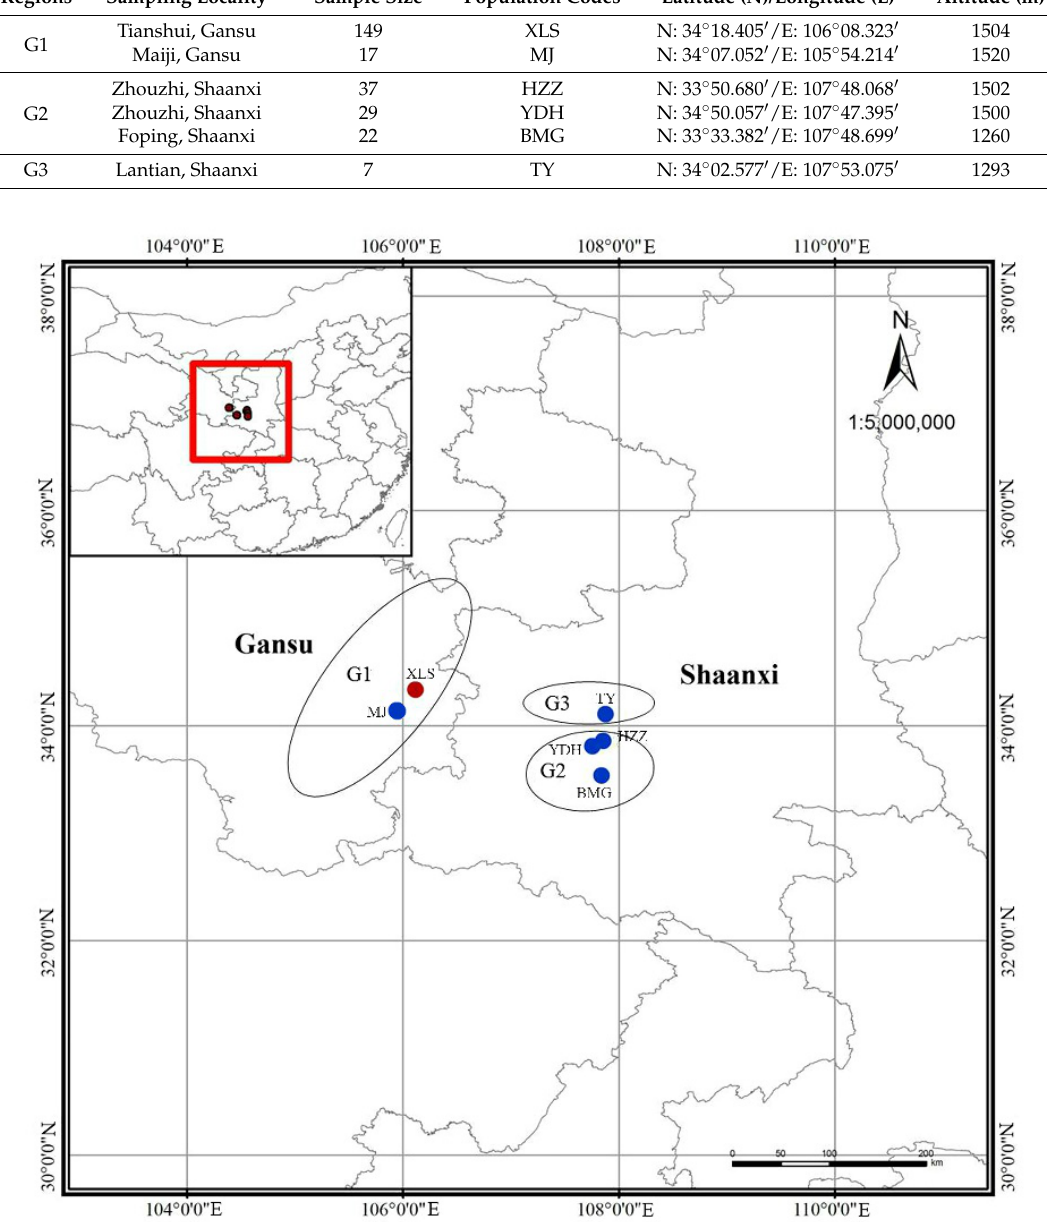
Figure 1. Geographic distribution of Acer miaotaiense collected in Qinling Mountains, China. Red dots represent genetic cluster C1, blue dots represent genetic cluster C2. Table 1. Summary of A. miaotaiense sampling locations in China.